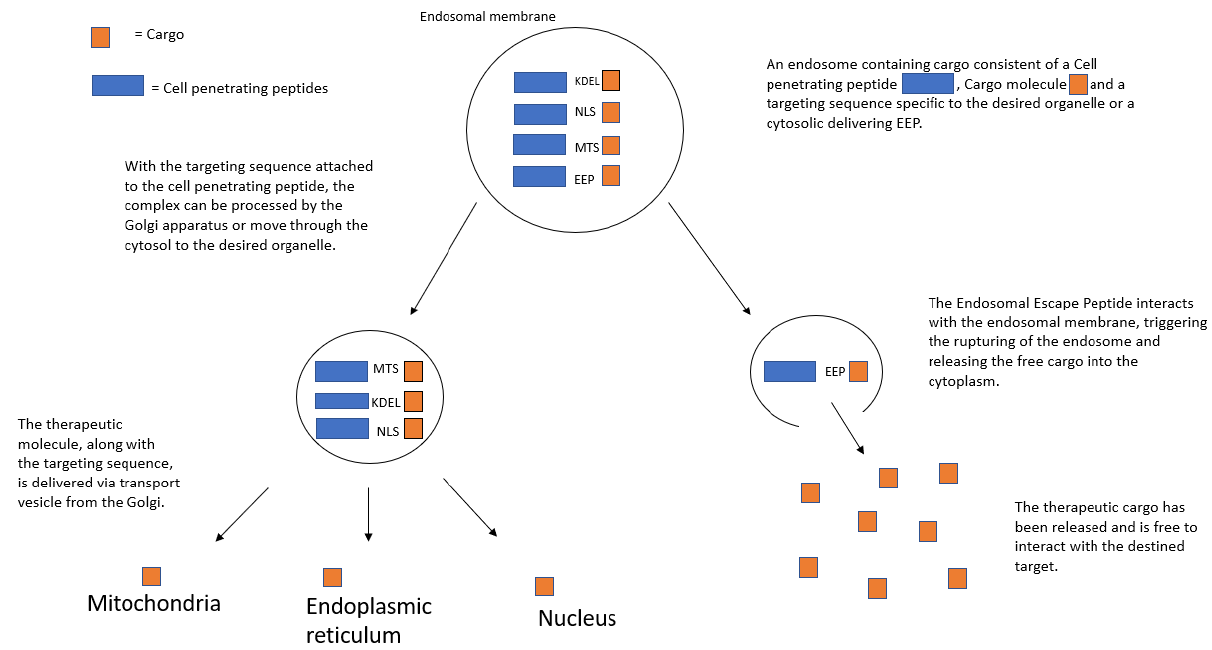
Figure 1. CPP-guided organelle targeting